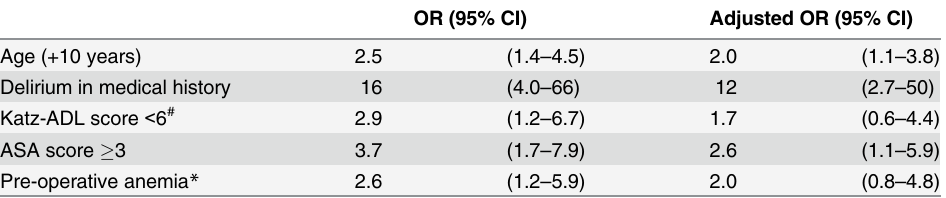
Table 4. Univariate and multivariate logistic regression analysis on risk factors for delirium of all included patients having elective surgery for AAA or colorectal